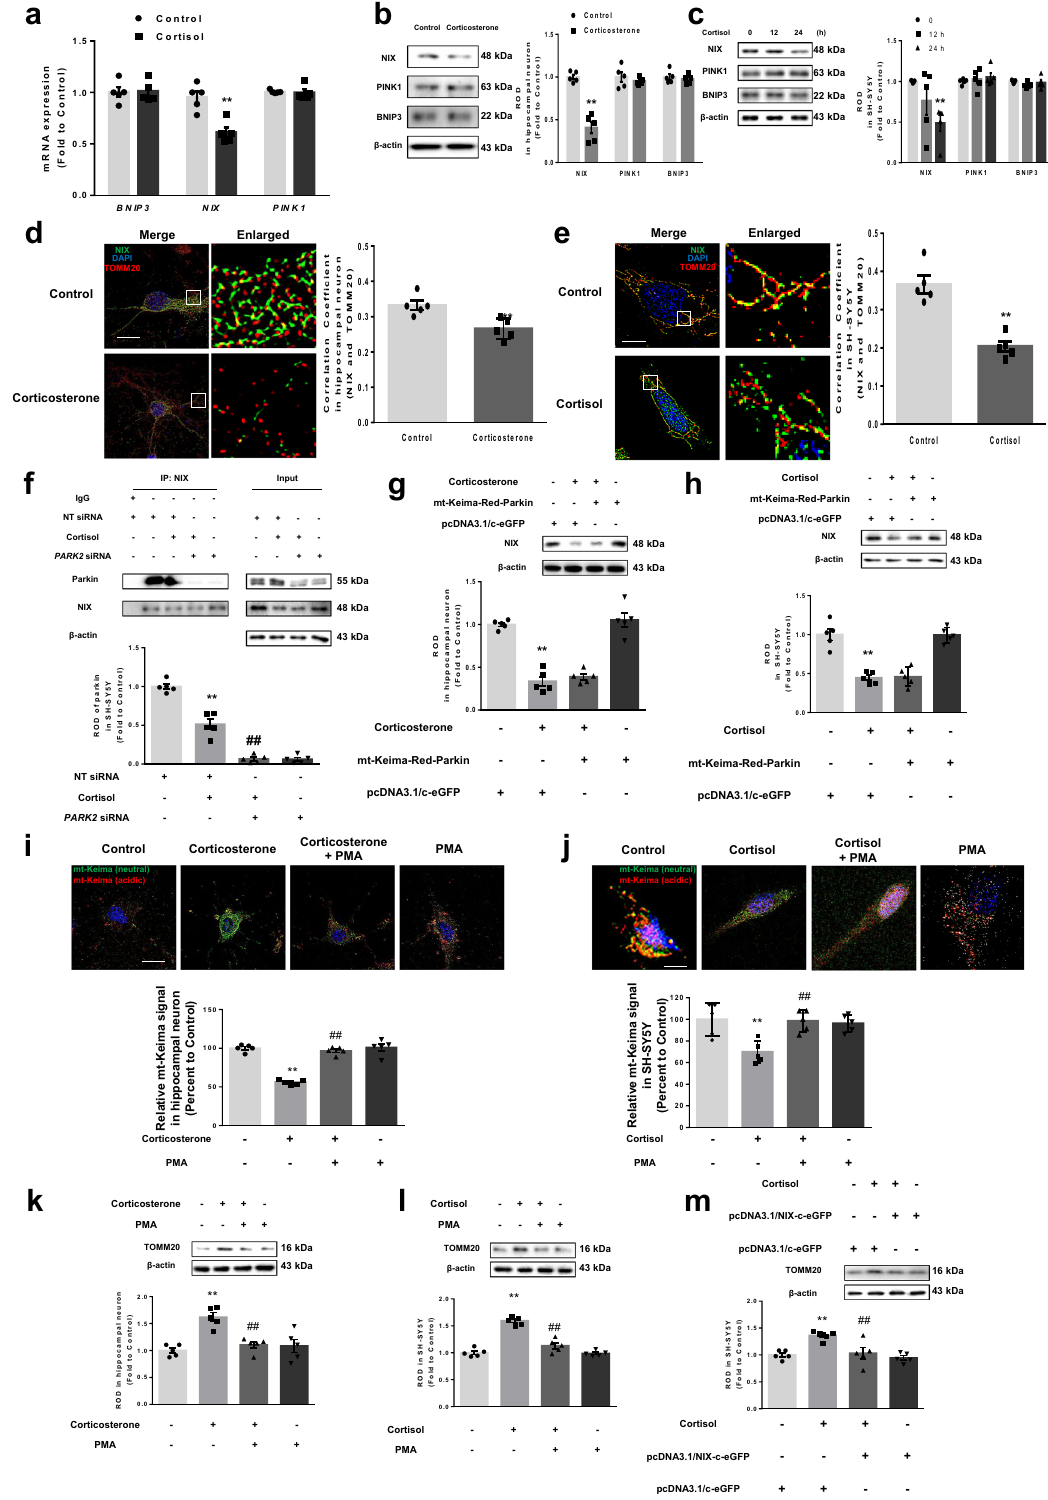
doses of corticosterone (10 mg/kg) following the drug regime (Supplementary Fig. 5a). To assess mitophagy using immunos- taining, we stained the brain tissue with LAMP1 and TOMM20 antibody for determining the fusion of lysosome and mitochon- dria, which form mitolysosome. NIX upregulation by PMA increased colocalization between LAMP1 and TOMM20, meaning